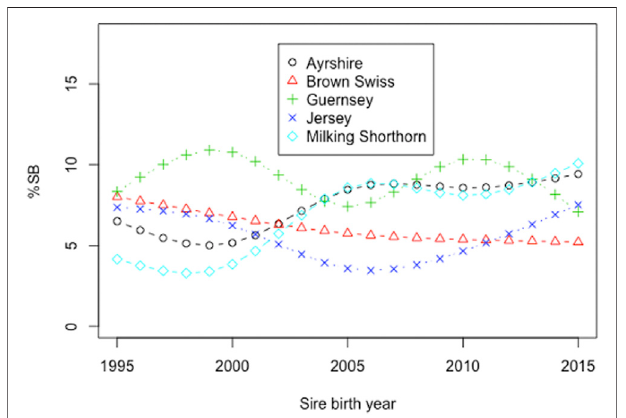
FIGURE 4 | Phenotypic trends for the stillbirth percentage (%SB) in heifers by birth year of sires in fi ve non-Holstein dairy cattle.